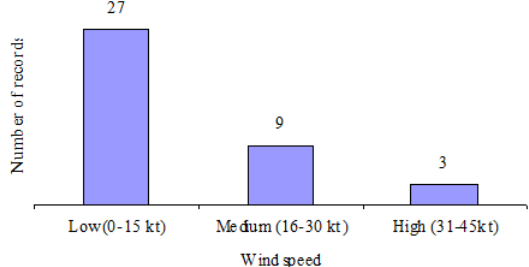
Figure 6. Response parameters versus number of times being changed in encounter records